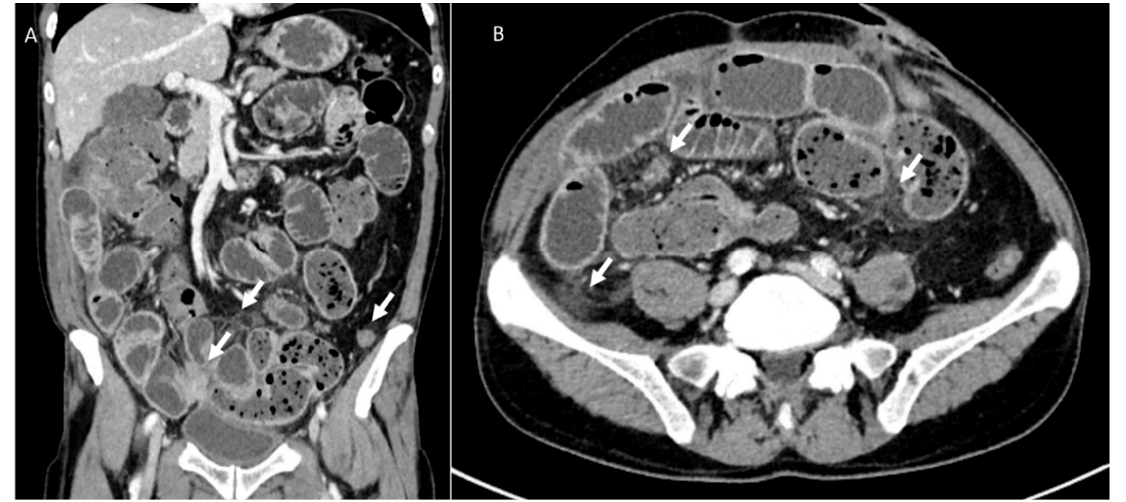
Figure 7. CT assessment during follow-up of rectal surgical-treated patient. In the MPR coronal plane ( A ) and axial plane ( B ), arrows show peritoneal carcinosis with intestinal occlusion.